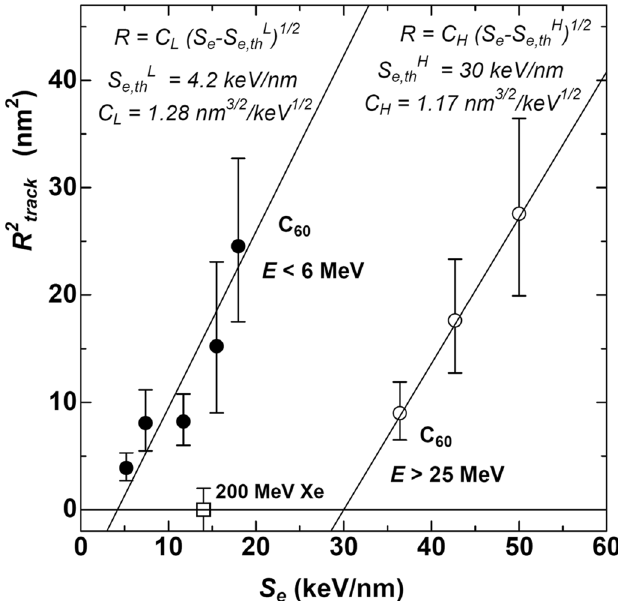
Figure 3. The energy dependence data of the track radii shown in Fig. 1a were plotted with the squared radius R 2 versus electronic stopping power S e . The solid liens indicate the square root laws as shown by Eq. (2b). The high (open circles) and low (closed circles) energy data fall on the same law with different parameters. The thresholds and the prefactors fitted at high and low energy regions were denoted by S e,th H , C H , and S e,th L , C L , respectively. A data point of 200 MeV Xe ion is also